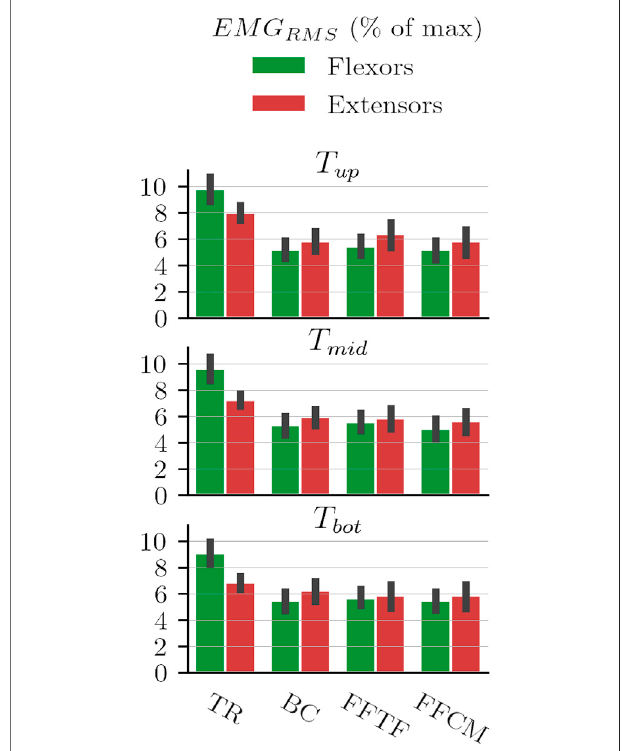
FIGURE 10 | RMS of EMG signals during static position maintenance at the three